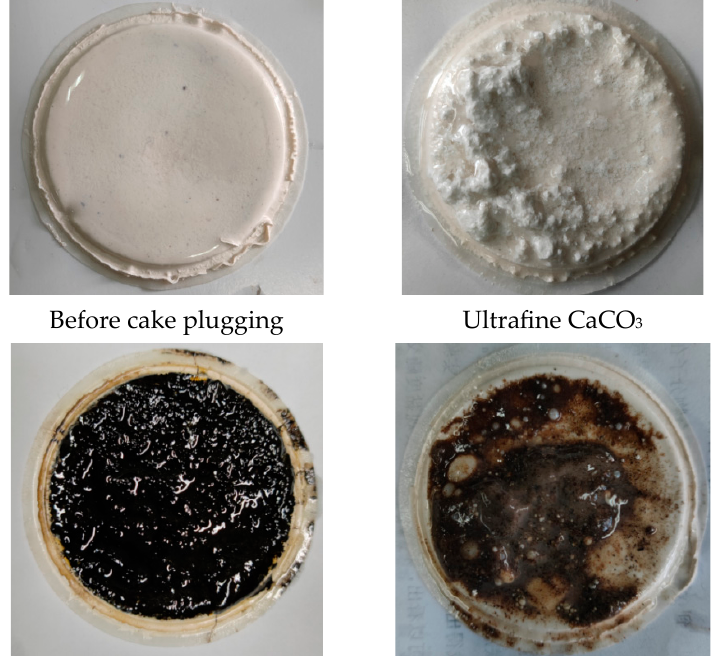
Figure 4. Comparison chart of fi lter cake before and after plugging.